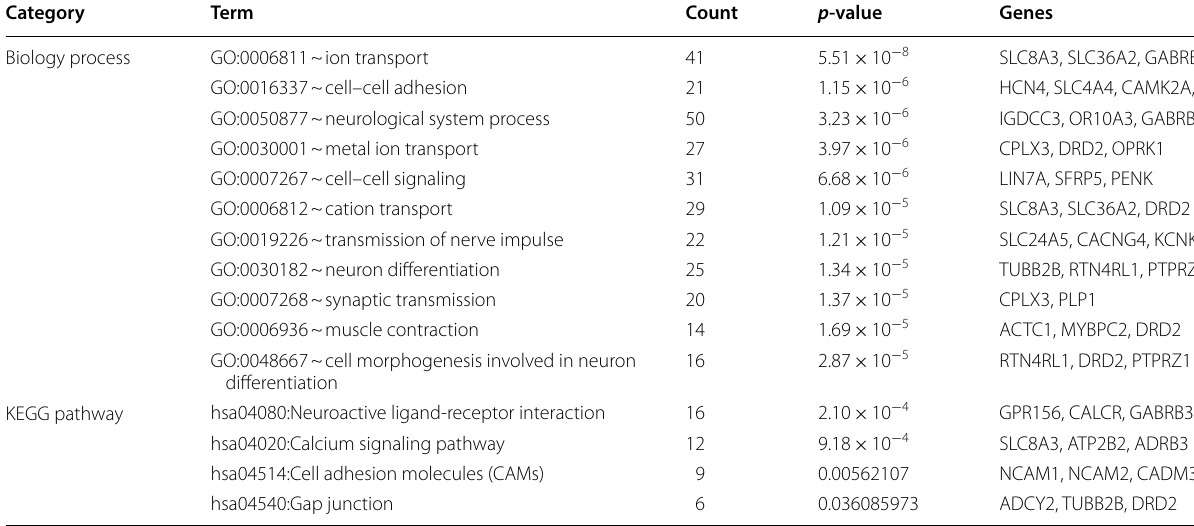
Table 4 GO and KEGG enrichment analyses of